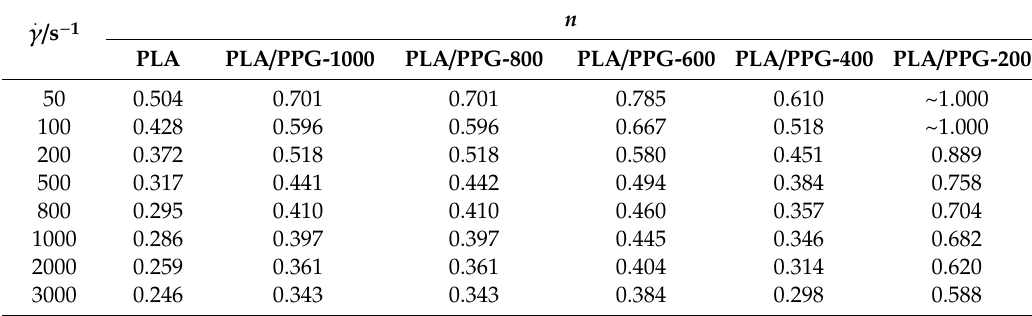
Table 1. n values for the neat PLA and PLA / PPG composites at various shear